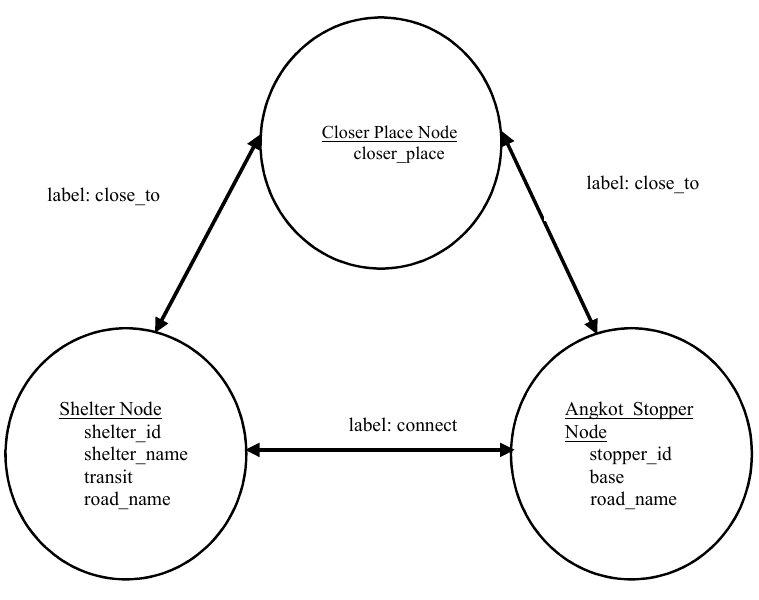
Fig. 3 Graph database schema for multimodal